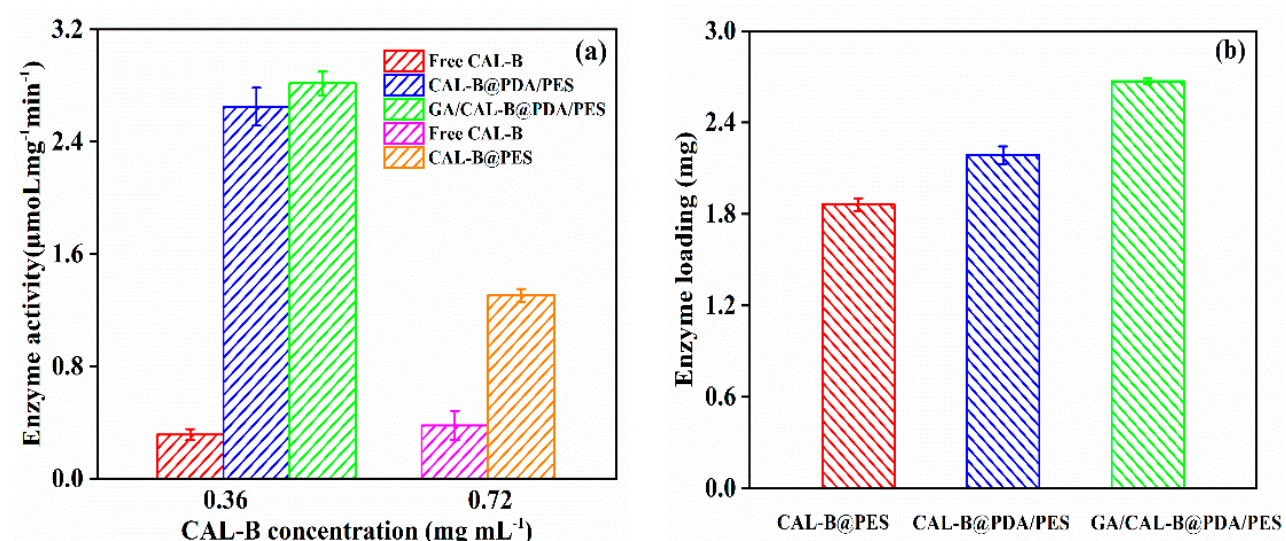
Figure 8. ( a ) Enzyme activity, and ( b ) enzyme loading, for BLIMs.